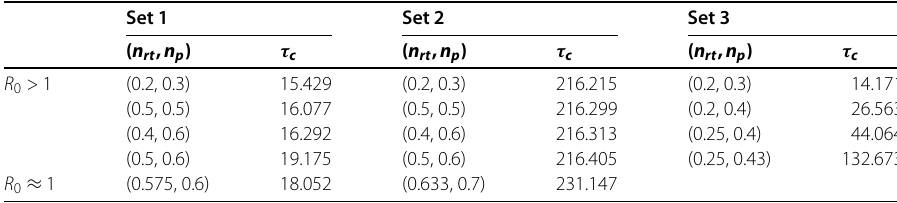
Table 15 Examples of critical delay times τ c (days) for Andronov-Hopf bifurcation Set 1 Set